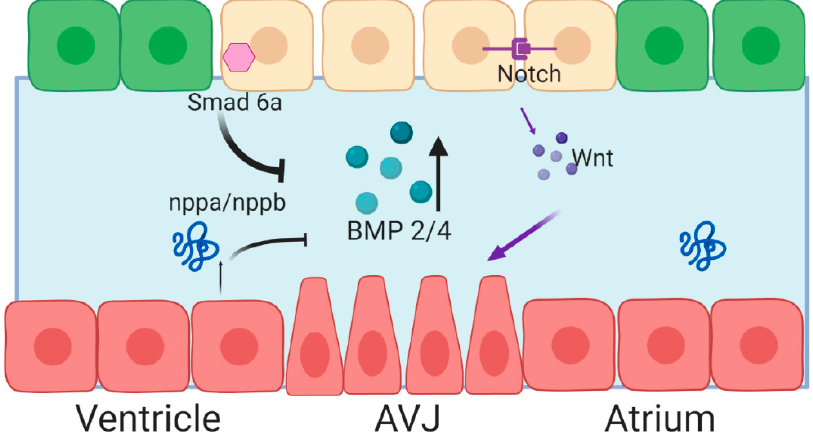
Figure 2. Spatiotemporal expression of Bone Morphogenetic Protein (BMP) 2 / 4 is achieved through activation at the AVJ, and repression through the cardiac chambers. Red cells represent myocardial cells, green cells represent endocardial cells, yellow cells represent valve-forming endocardial cells. Blue space between the two cell layers represents the cardiac jelly. Figure created with